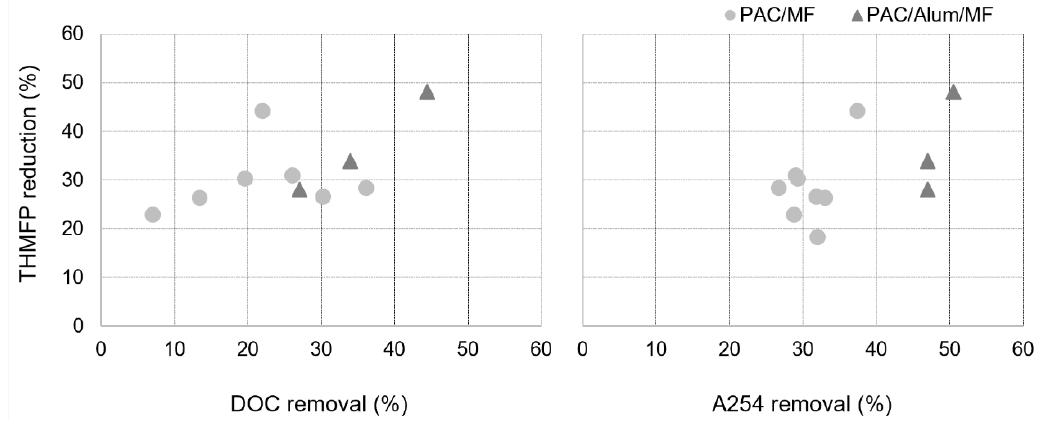
Figure 9. Trihalomethane formation potential (THMFP) reduction by PAC/MF and PAC/Alum/MF and NOM removal in terms of DOC ( left ) or A254 ( right ).